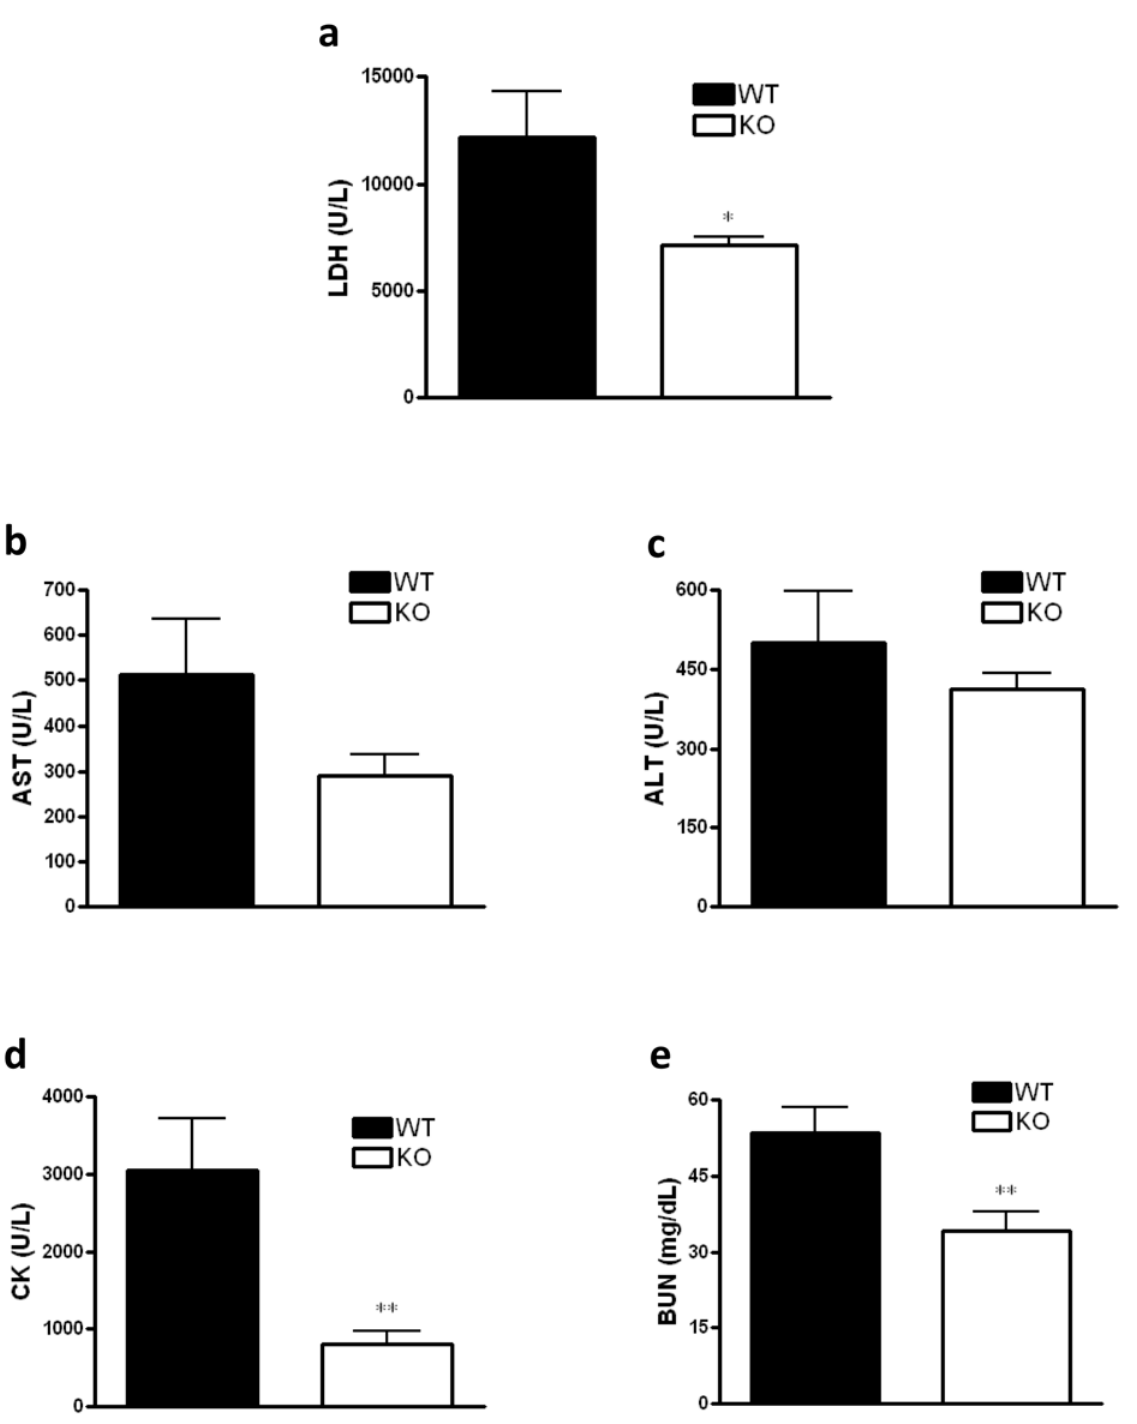
Figure 3. CB 2 KO mice have less tissue damage, kidney and muscle injury in sepsis than their WT counterparts. LDH (a) , AST (b) , ALT (c) , and CK (d) activity, and BUN (e) levels were measured in plasma samples 16 hour after CLP using a clinical chemistry analyzer system (VetTest8008, IDEXX Laboratories). Data are the mean 6 SEM of n =6–9 mice per group. ** p , 0.01; * p , 0.05.